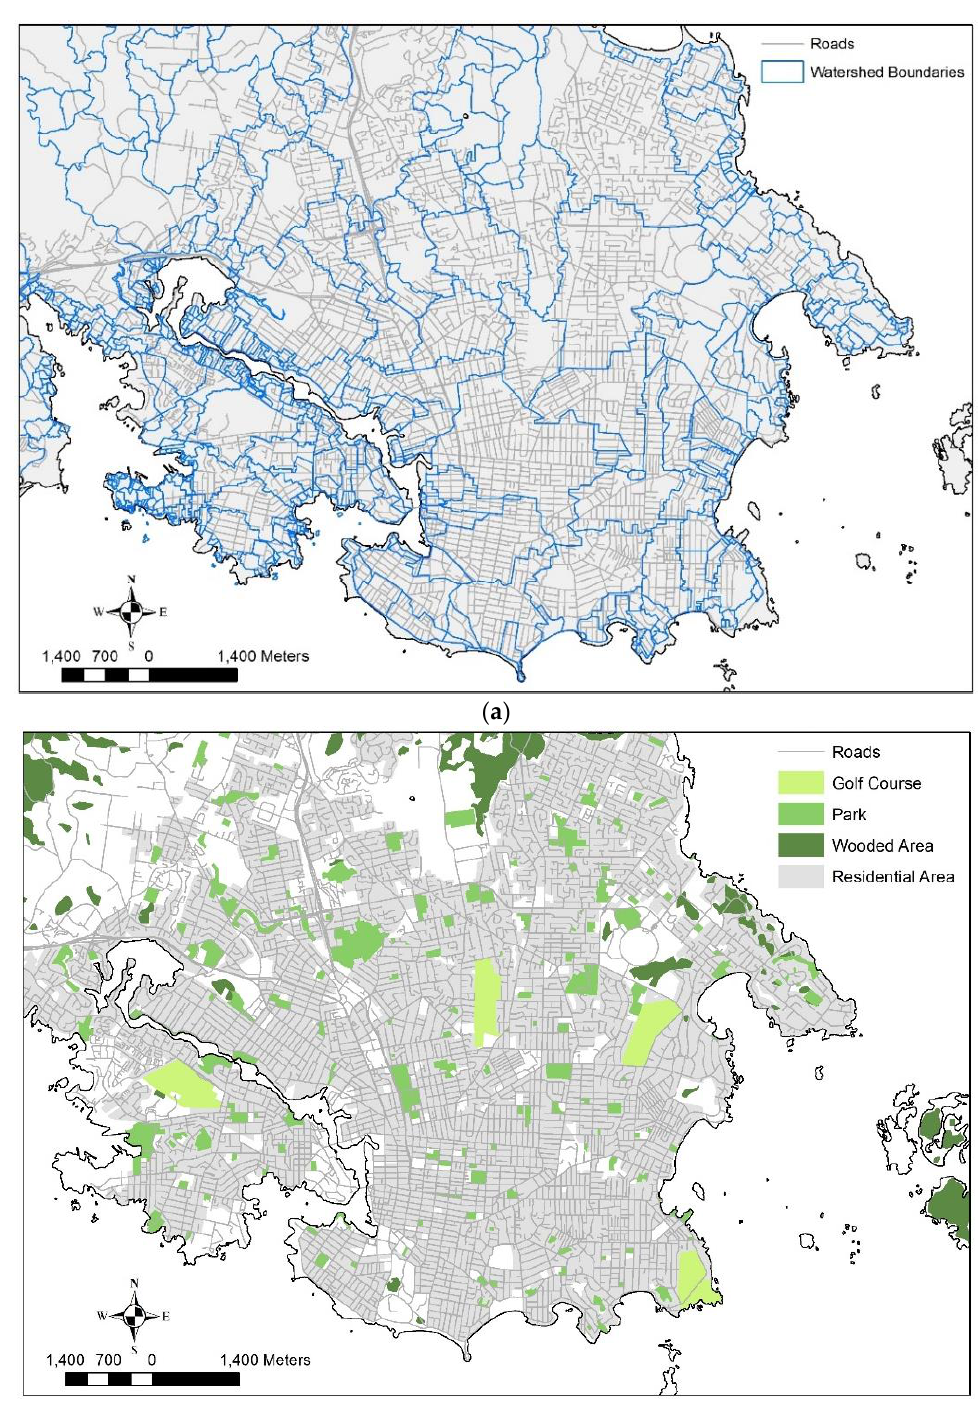
Figure 2. ( a ) Watershed map in Capital Region District; ( b ) Land-use map in Capital Region District.